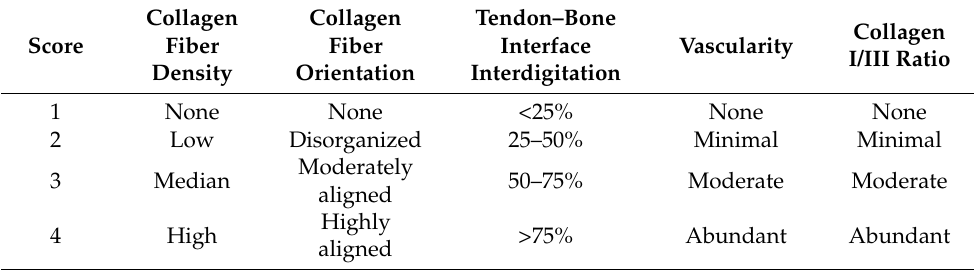
Table 1. Modified histologic grading system for rotator cuff tear